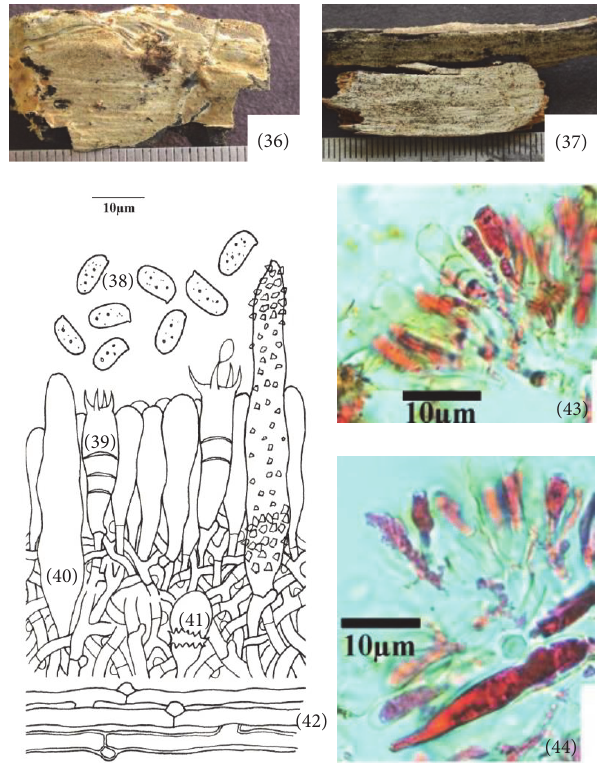
Figure 6: Hyphoderma subpraetermissum (36)–(44). (36) Fresh basidiocarp, (37) dried basidiocarp, (38) basidiospores, (39) basidium, (40) cystidium, (41) stephanocyst, (42) generative hyphae, (43) photomicrographs showing basidium, and (44) microphotographs showing